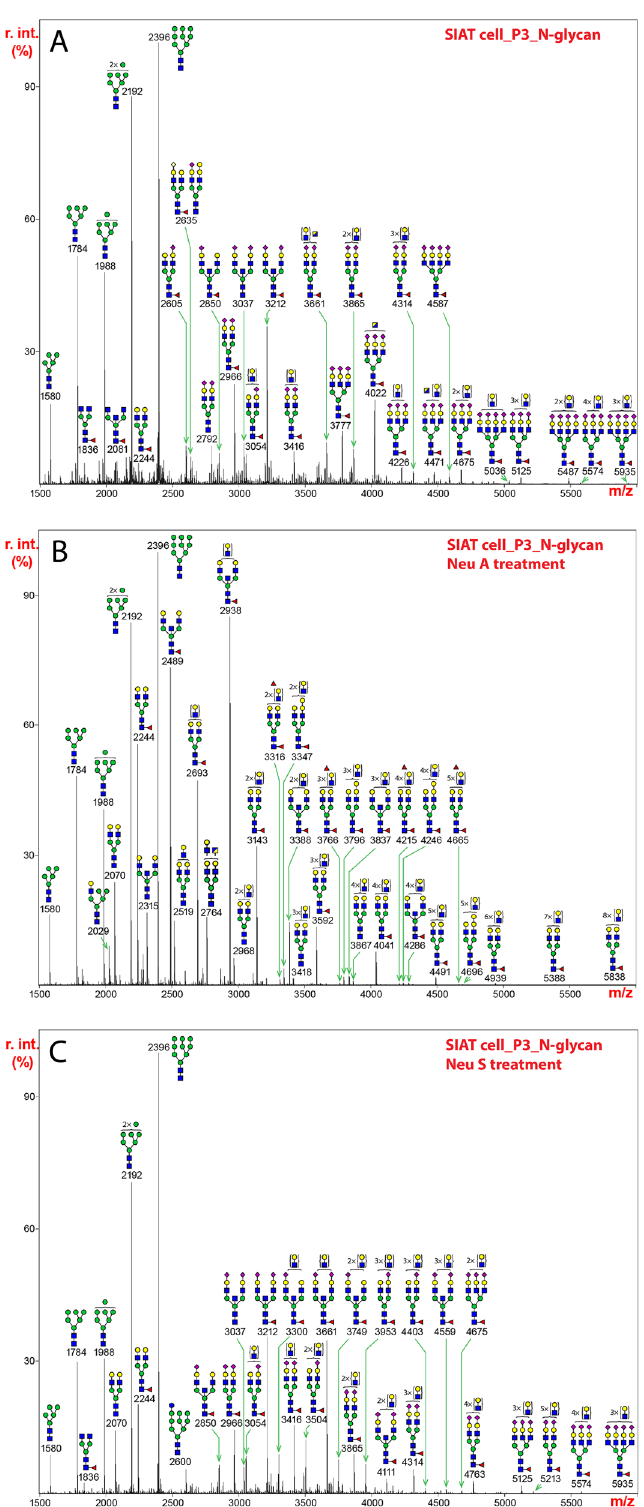
Figure 2. N-glycans released from extracts of SIAT1 cells by treatment with PNGase F, permethylated, and analyzed by MALDI-TOF MS. The medial molecular range between m/z 1500 and 5500 is shown. Putative structures based on compositions and corresponding to masses detected are represented next to the corresponding mass peaks. ( A ) N-glycans from SIAT1 cells at passage 3. ( B ) N-glycans in ( A ) from extracts of SIAT1 cells at passage 3 were treated with neuraminidase A and analyzed. ( C ) N-glycans in ( A ) from extracts of SIAT1 cells at passage 3 were treated with neuraminidase S and analyzed. The assignments of N-glycan mass and compositions, as well as relative percentage abundance of each glycan species in ( A ), ( B ), and ( C ) are presented in Supplementary Table